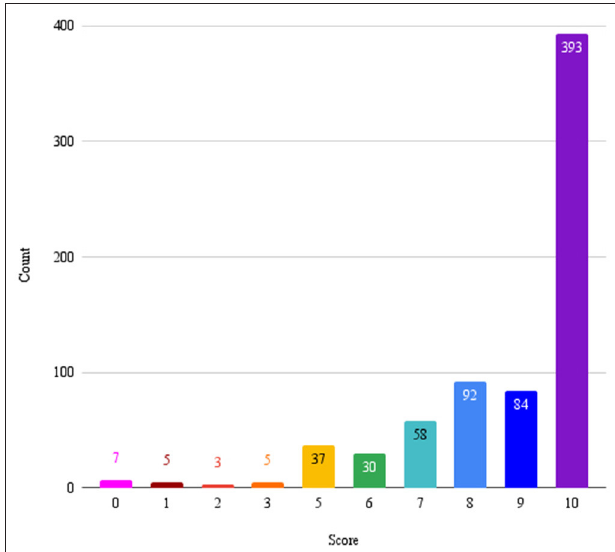
FIGURE 1 | Each bar represents the number of times each possible NPS score was given by users.